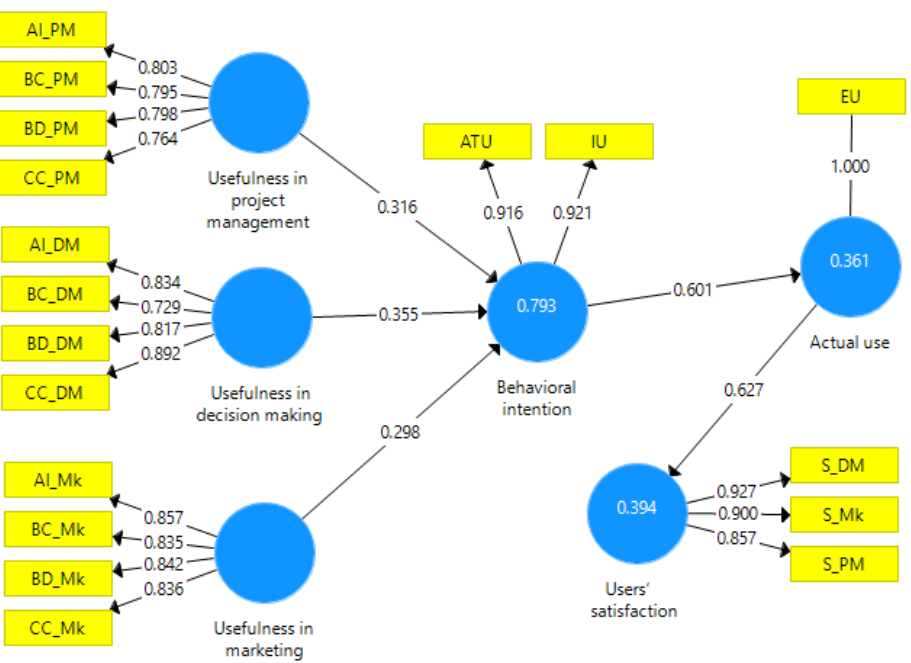
Figure 3. Applied model. Source: own construction using SmartPLS v3.0. Table 3. Validity and